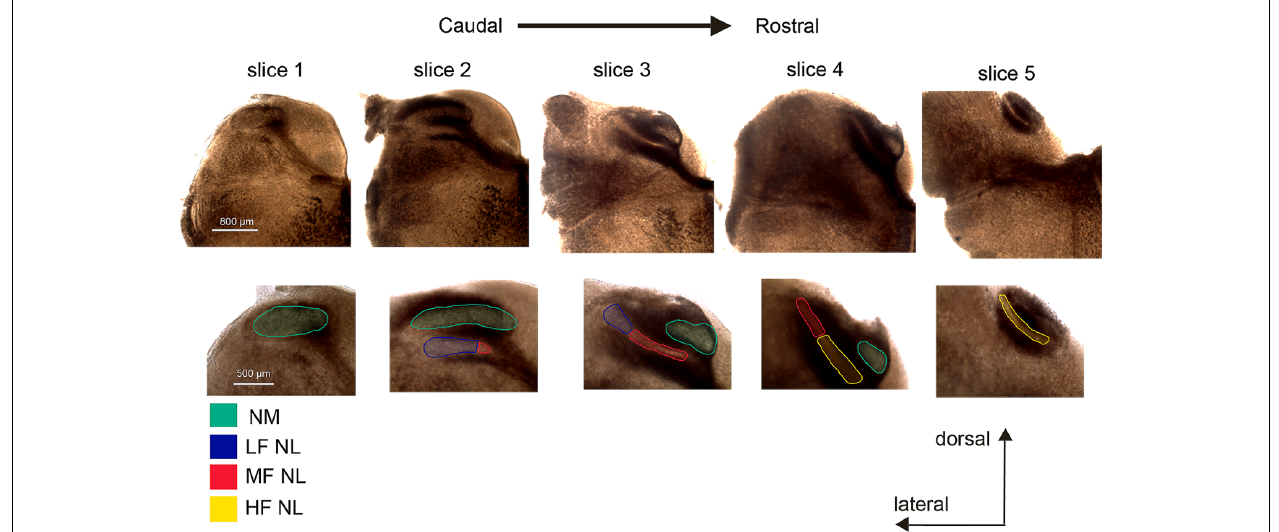
blue) neurons, with some middle frequency (MF, red) neurons present at the most medial end. MF neurons are most prevalent in slice #3, with LF neurons at the lateral end of the nucleus. In slice #4, HF (yellow) neurons are located in the medial portion of the NL while MF neurons are found laterally. In slice #5 only HF neurons are present.The colored boundaries between CF regions are